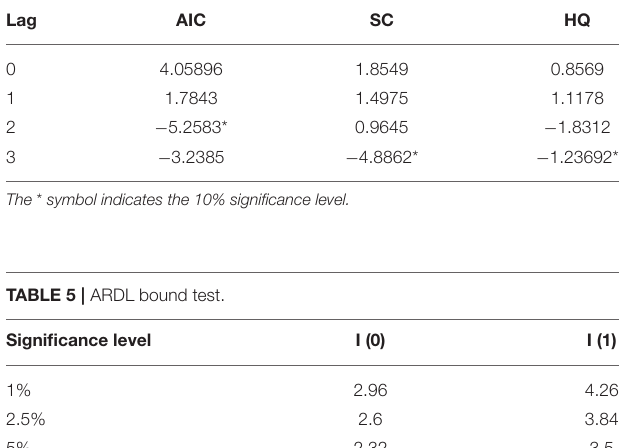
TABLE 4 | Lag selection criteria.